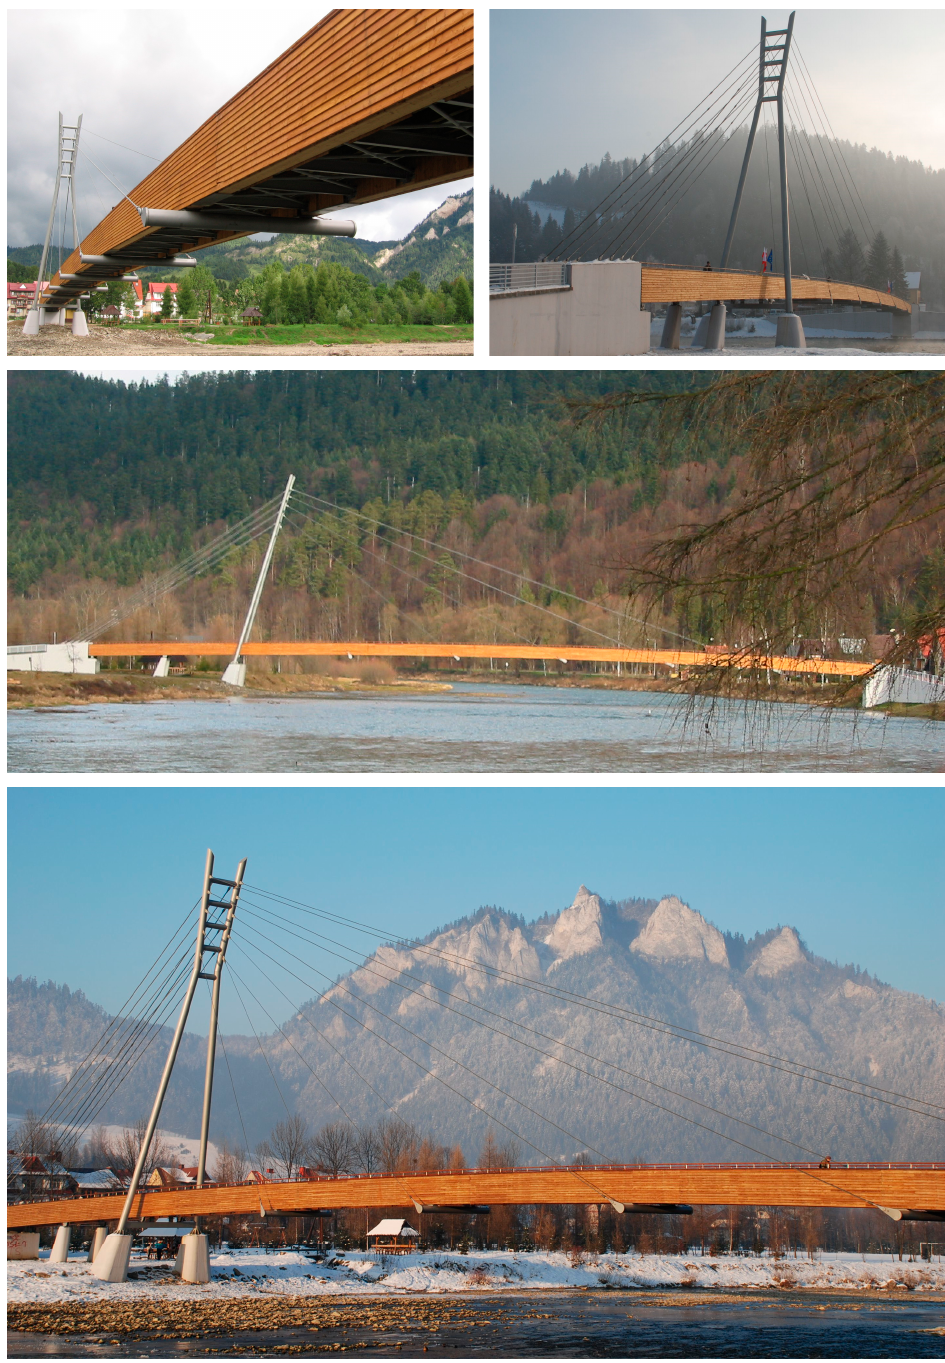
Figure 2. The cable ‐ stayed footbridge in the Pieniny mountains made of glued ‐ laminated wood. The wooden deck is supported by five pairs of stays in a distance of 15.0 m. The stay cable system was manufactured by Pfeifer (Figure 5). Full locked cables of Ø40 mm or Ø28 mm were used in the main span and tensioned rods type 860 of Ø60 mm or Ø52 mm were used for the back ‐ stays. The pylon was constructed from steel tubes with a diameter of 508 mm and was inclined in the direction of the main span. The height of the pylon is 26.84 m above the concrete support.